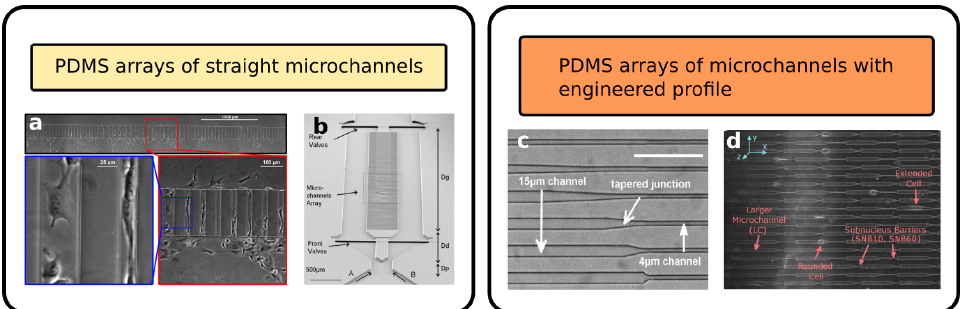
Figure 2. Examples of cellular migration assay realized with arrays of straight microchannels in PDMS: ( a ) array of microchannel connecting culture and chemoactractant chambers. Each panel is a close-up of the previous, showing the detail of the array and the shape of the cells in two channels with two different widths (Reprinted with permission from Ref. [49] Copyright 2012 Tong et al.); ( b ) advanced geometry integrating several components in the same device, such as: an array of straight channels (center), a connection channel to balance the chemical gradient (bottom) and two microfluidic valves (top and bottom) (Reprinted with permission from Ref. [50] Copyright 2007, The Royal Society of Chemistry); ( c ) variable cross-section channels with different tapering angles (Reprinted with permission from Ref. [53] Copyright 2011, Mak et al.); ( d ) array of microchannels with periodically modulated width (Reprinted with permission from Ref. [54] Copyright 2013, The Royal Society of